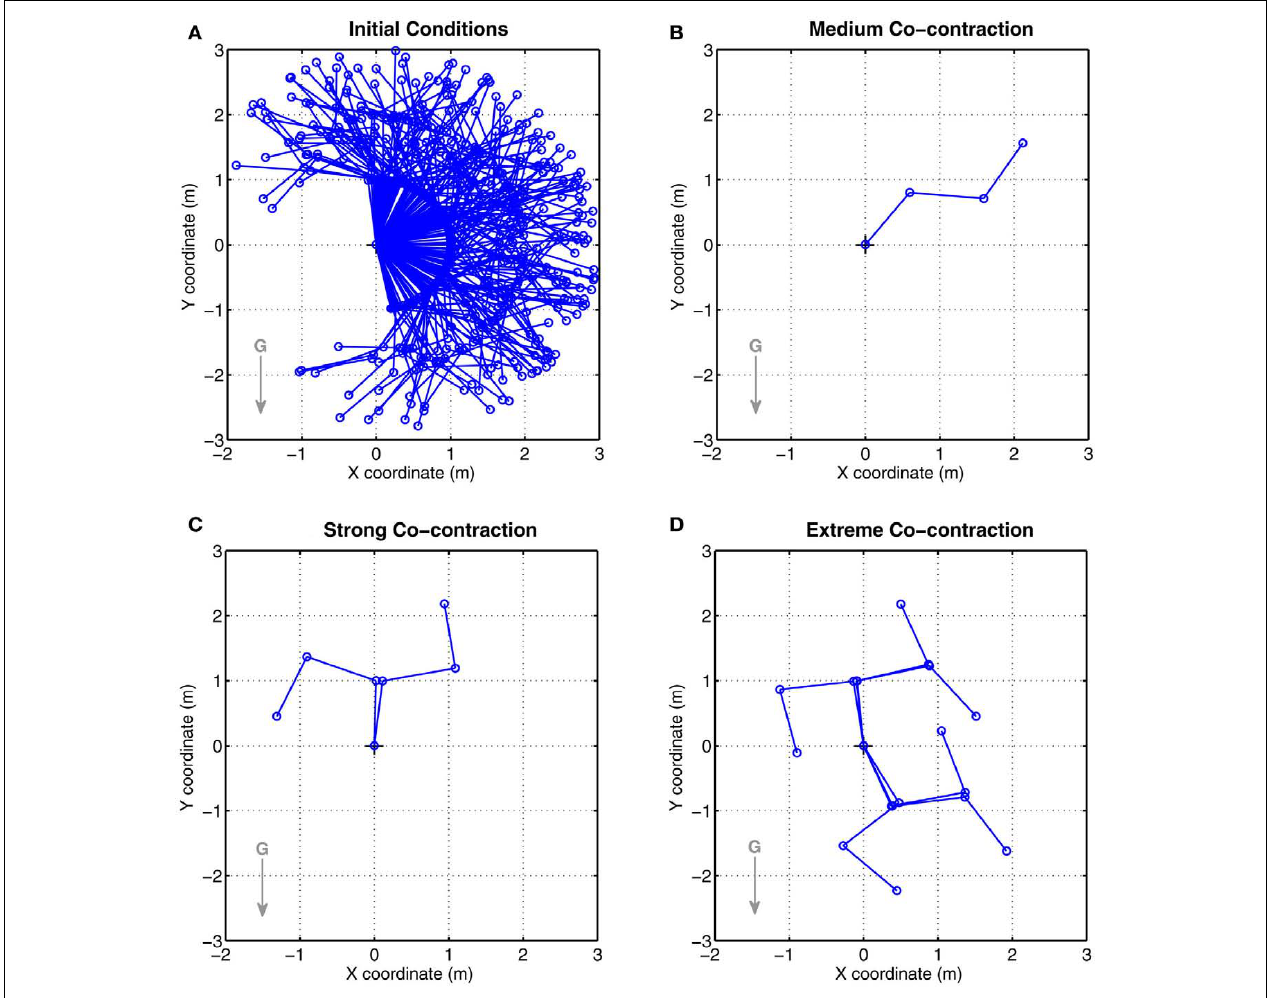
Figure 6 . All limbs undergoing medium co-contraction converged to same final posture whereas those undergoing strong and extreme co-contraction converged to non-unique final postures.These observations are consistent with the findings of bistability in the isolated limb segment. See Movie S2 in Supplementary Material for an animated version of this